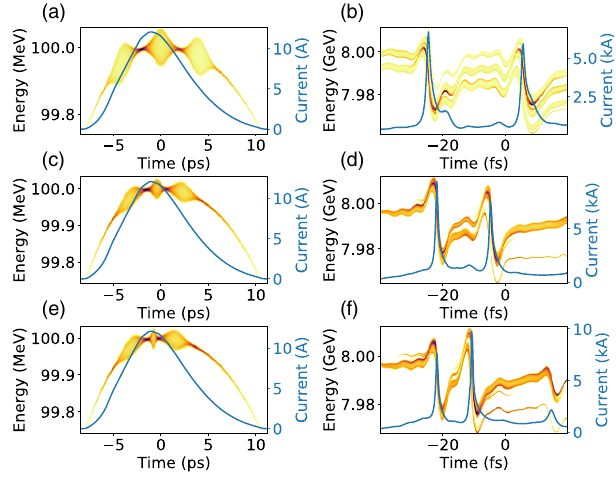
FIG. 7. Longitudinal phase space after the laser heater (a, c, e) and right before the hard x-ray undulator line (b, d, f) for shaped beams with two current spikes. The delay time between the two spikes are 31.0 fs (a, b), 17.3 fs (c, d), and 9.5 fs (e, f)